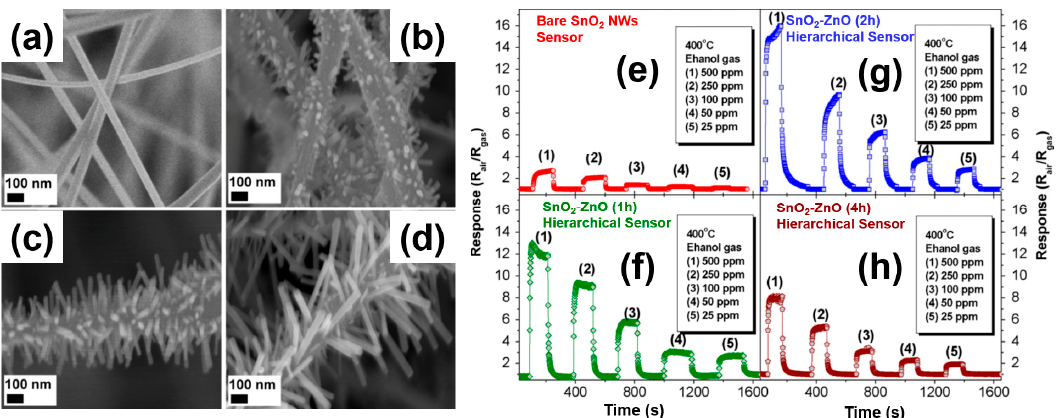
Figure 19. Left figure: branches nanowire with different length on ZnO nanowires: ( a ) as fabricated ZnO nanowires; ( b ) 1h growth SnO 2 branched ZnO nanowire; (c) 2h growth; ( d ) 4h growth. Right figure: SnO 2 nanowire and SnO 2 –ZnO hierarchical structure sensing performance; ( e ) as fabricated ZnO nanowires; ( f ) 1h growth SnO 2 branched ZnO nanowire; ( g ) 2h growth; and ( h ) 4h growth. Reprinted from reference [321] with permission from the American Chemical Society.